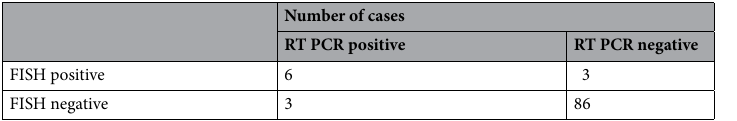
Table 1. Comparison of results of RT-qPCR and FISH methods used in assessment of ROS1 rearrangements.